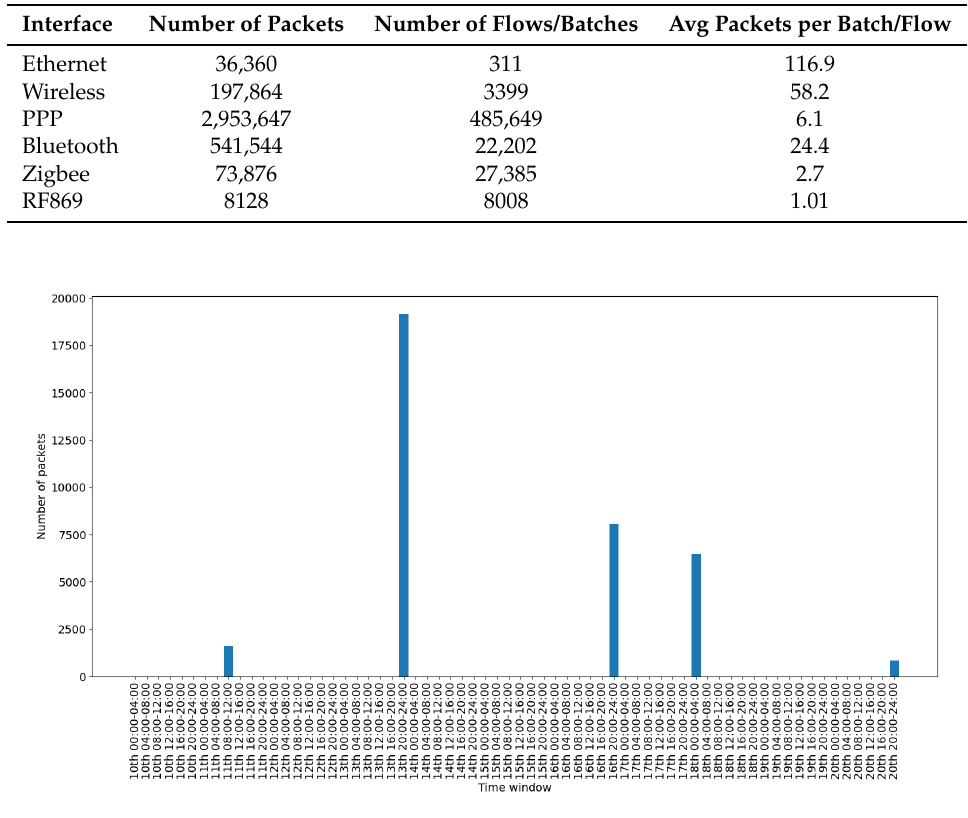
Figure 8. Ethernet packets time distribution.